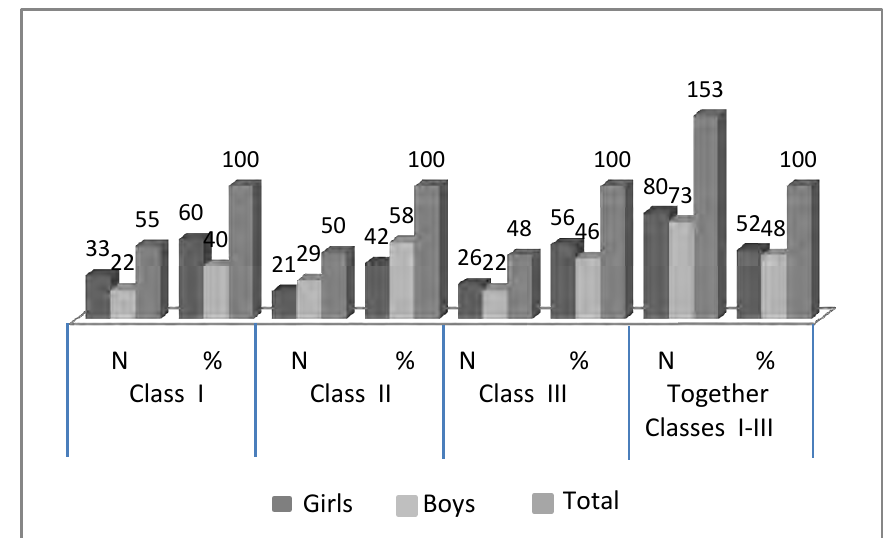
Figure 1. Proportional participation of the subjects including class and